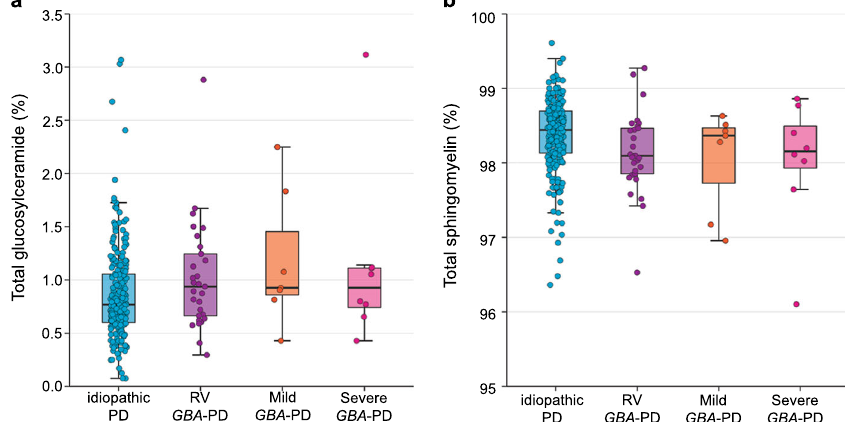
Fig. 2 Glucosylceramide and sphingomyelin in PD patients with distinct types of GBA variants. a Glucosylceramide fraction in patients with idiopathic PD and in GBA -PD patients carrying risk variants (RV), mild mutations, and severe mutations. b Sphingomyelin fraction in patients with idiopathic PD and in GBA -PD patients with risk variants (RV), mild mutations, and severe mutations. Unadjusted sphingolipid fractions in CSF of 271 PD patients are shown in box and jitter dot Strati fi cation of idiopathic PD based on the ratio of glucosylceramide to sphingomyelin (GlcCer/SM ratio) We then sought to explore whether this GBA mutation-linked sphingolipids pro fi le (characterized by an elevated glucosylcer- amide fraction and a reduced sphingomyelin fraction) is useful for stratifying common, idiopathic PD patients without known GBA mutations. To that end we strati fi ed the patients with de novo, idiopathic PD in PPMI based on their ratio of glucosylceramide to sphingomyelin (GlcCer/SM ratio) measured at baseline. We then asked whether patients in the highest quartile of the GlcCer/SM ratio had a more rapid cognitive disease progression compared to those patients within the lowest quartile of the GlcCer/SM ratio. We compared longitudinal MoCA scores of idiopathic PD patients quartile of GlcCer/SM ratio at baseline compared to those in the lowest quartile (Supplementary Table 5). There was no difference